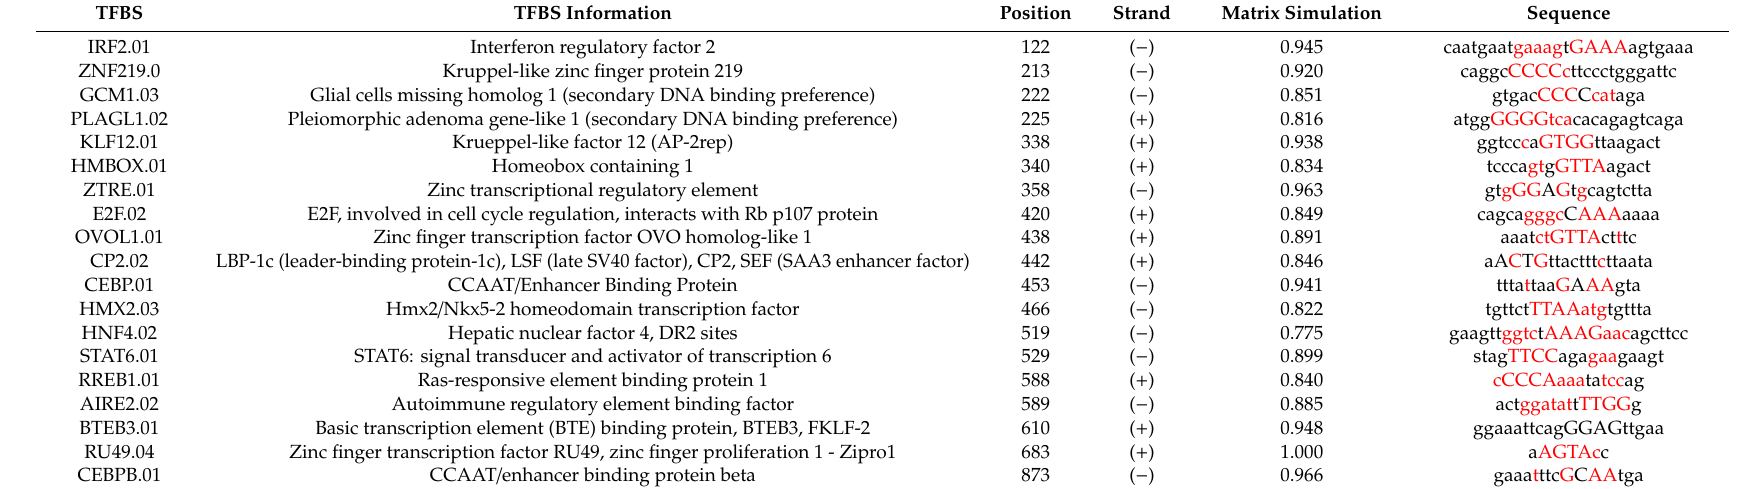
Table 3. List of transcription factor binding sites associated with N’Dama-specific CD14 gene promoter SNPs.